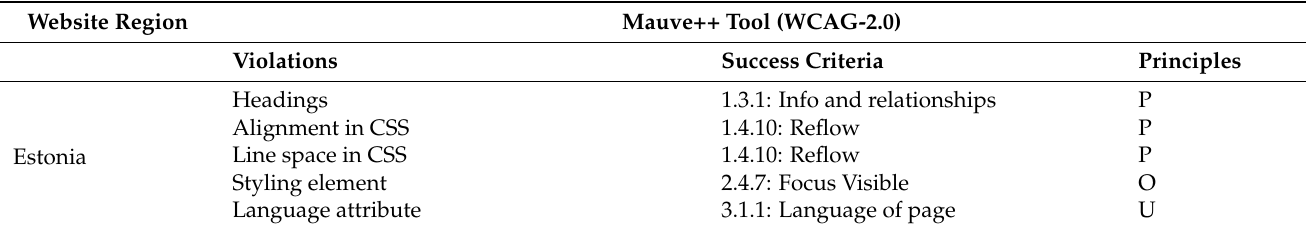
Table A1. Accessibility issues in the website of each country for WCAG